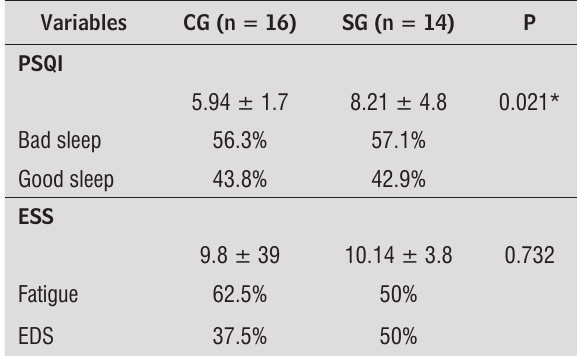
Table 2 - Sleep quality comparison and the occurrence of excessive daytime sleepiness between the control